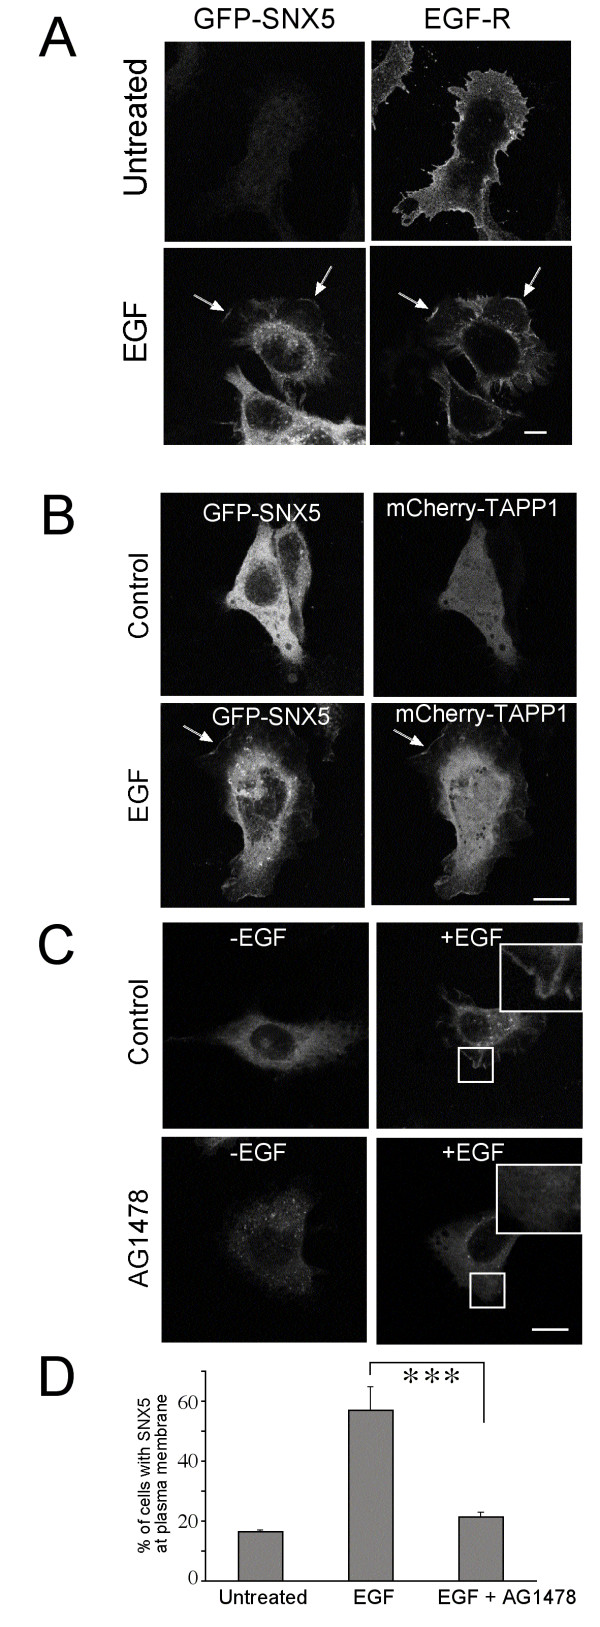
SNX5 is recruited to regions of the plasma membrane rich in PI(3,4)P2. (A) HEK-GFP-SNX5 cells were transfected with EGF-R and 24 h later serum-starved overnight and either left untreated or treated with 100 ng/ml EGF for 3 min at 37°C, as indicated. Cells were fixed and stained with anti-human EGF-R antibody followed by Alexa568-conjugated goat anti-mouse IgG for detection of surface EGF-R. Optical sections were taken to highlight the plasma membrane. Arrows indicate membrane ruffles showing co-localization of GFP-SNX5 and EGF-R (B) HEK-GFP-SNX5 cells were transfected with mCherry-TAPP1-PH and 24 h later serum-starved overnight then either left untreated or treated with 100 ng/ml EGF for 5 min at 37°C and then fixed. Arrows indicate co-localization of GFP-SNX5 and mCherry-TAPP1-PH (C) HEK-GFP-SNX5 cells were serum-starved overnight and either left untreated or treated with 100 ng/ml EGF for 3 min at 37°C, in the presence or absence of 100 nM AG1478, as indicated, and fixed. Boxed images are shown magnified on upper right hand corner. (D). Cells from (C) were scored for plasma membrane GFP-SNX5 by epifluorescence microscopy. 100 cells in triplicate were analysed. Shown is mean and error bars represent standard deviation. *** p <0.005. Bars = 10 μm.